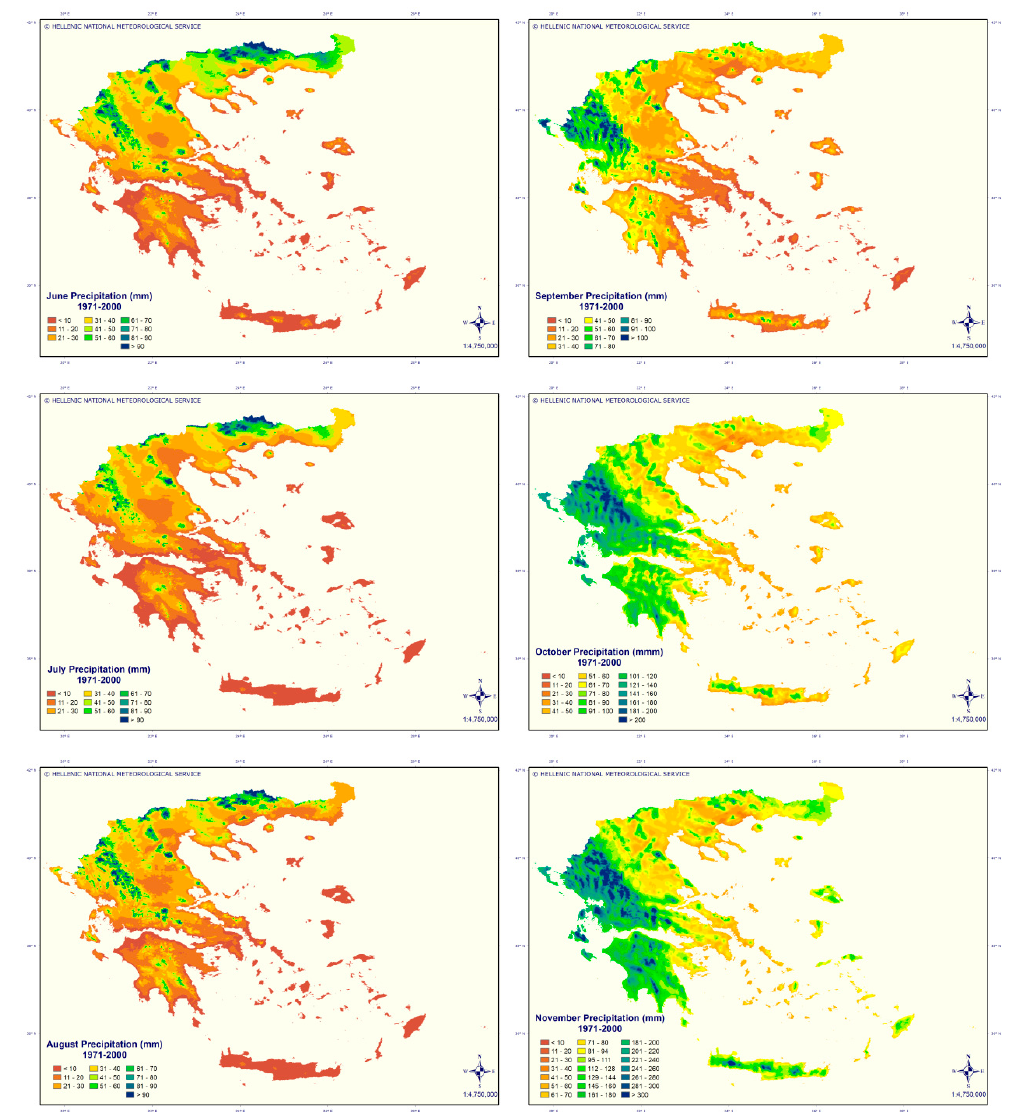
Figure 11. Precipitation maps for the period 1971–2000 for JJA months (left column) and SON months (right column).